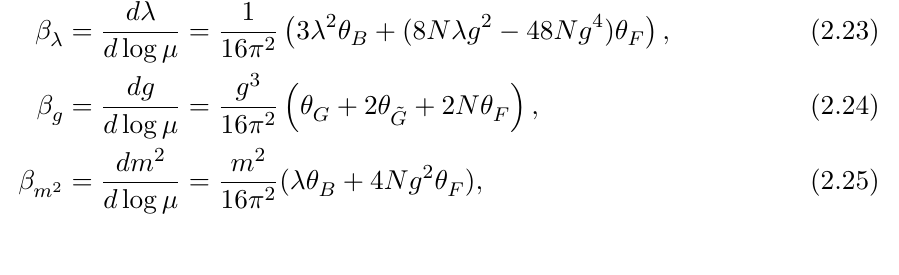
Figure 1 . The decoupling scales (cid:22) 10TeV. The decoupling scales are in between the mass scales of a heavy and a light particle and never coincide with the heavier mass